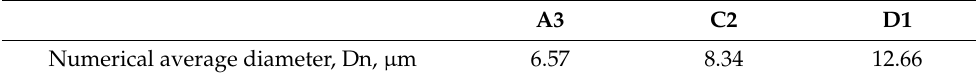
Table 7. Numerical average diameter values of A3, C2 and D1